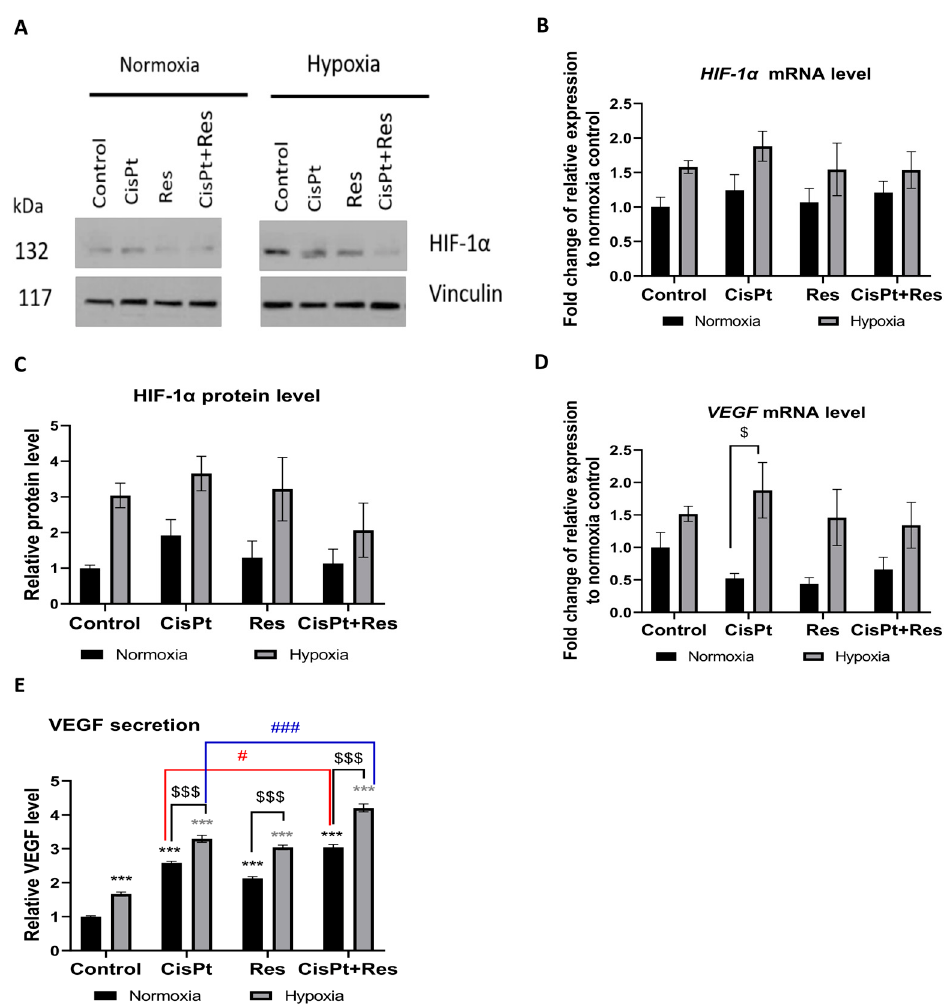
Figure 6. Hypoxia-modified HIF-1 α and VEGF mRNA and protein expression upon cisplatin, resveratrol, and the combination treatments. A2780 cells were treated with cisplatin (CisPt), resveratrol (Res), and the combination (CisPt+Res) according to Section 4.4: Establishment of Hypoxic Culture Conditions and Experimental Outline. ( A ) Immunoblots of HIF-1 α protein; ( B ) the level of HIF-1 α mRNA expression was measured by RT-qPCR and normalized to PPIA and GUSB expressions and normoxia control as 1; ( C ) densitometric analysis of HIF-1 α protein. Vinculin was used as a loading control and normalized to the normoxia control as 1; ( D ) the level of VEGF mRNA expression was measured by RT-qPCR and normalized to PPIA and GUSB expressions and the normoxia control as 1; ( E ) secretion of VEGF by A2780 cells was measured by the ELISA method and normalized to the normoxia control as 1. The results shown are the mean ±SEM of three independent experiments, with *** p < 0.001, vs. normoxia control (black asterisk) and vs. hypoxia control (grey asterisk); $$$ p < 0.001, $ p < 0.05, comparing the normoxia group with hypoxia group; and ### p < 0.001, # p < 0.05 CisPt alone vs. CisPt+Res.